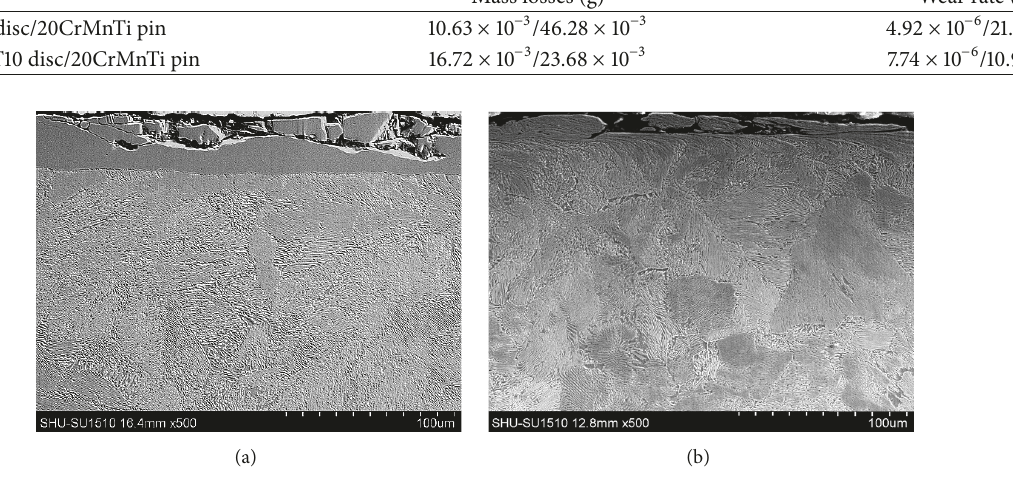
Figure 5: SEM cross-section micrographs of the (a) chroming and (b) nonchroming T10 discs.